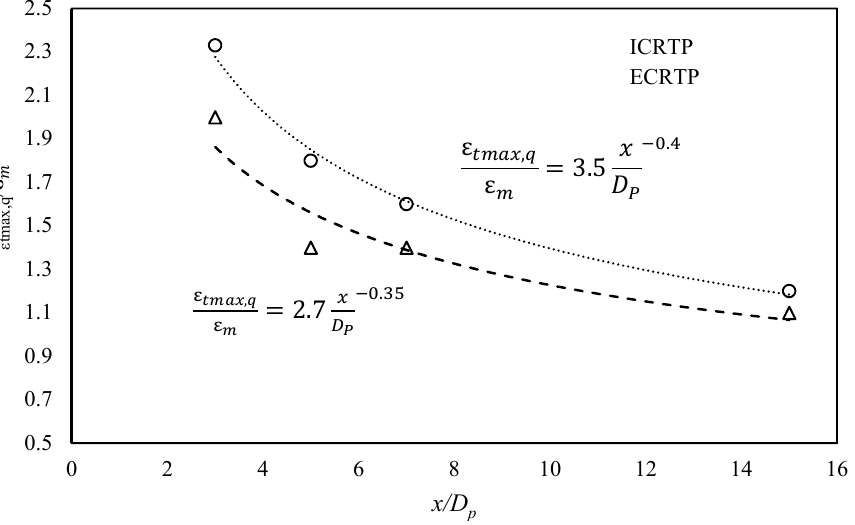
Figure 8. Prediction equation of maximum scour depth of twin propellers near quay wall.